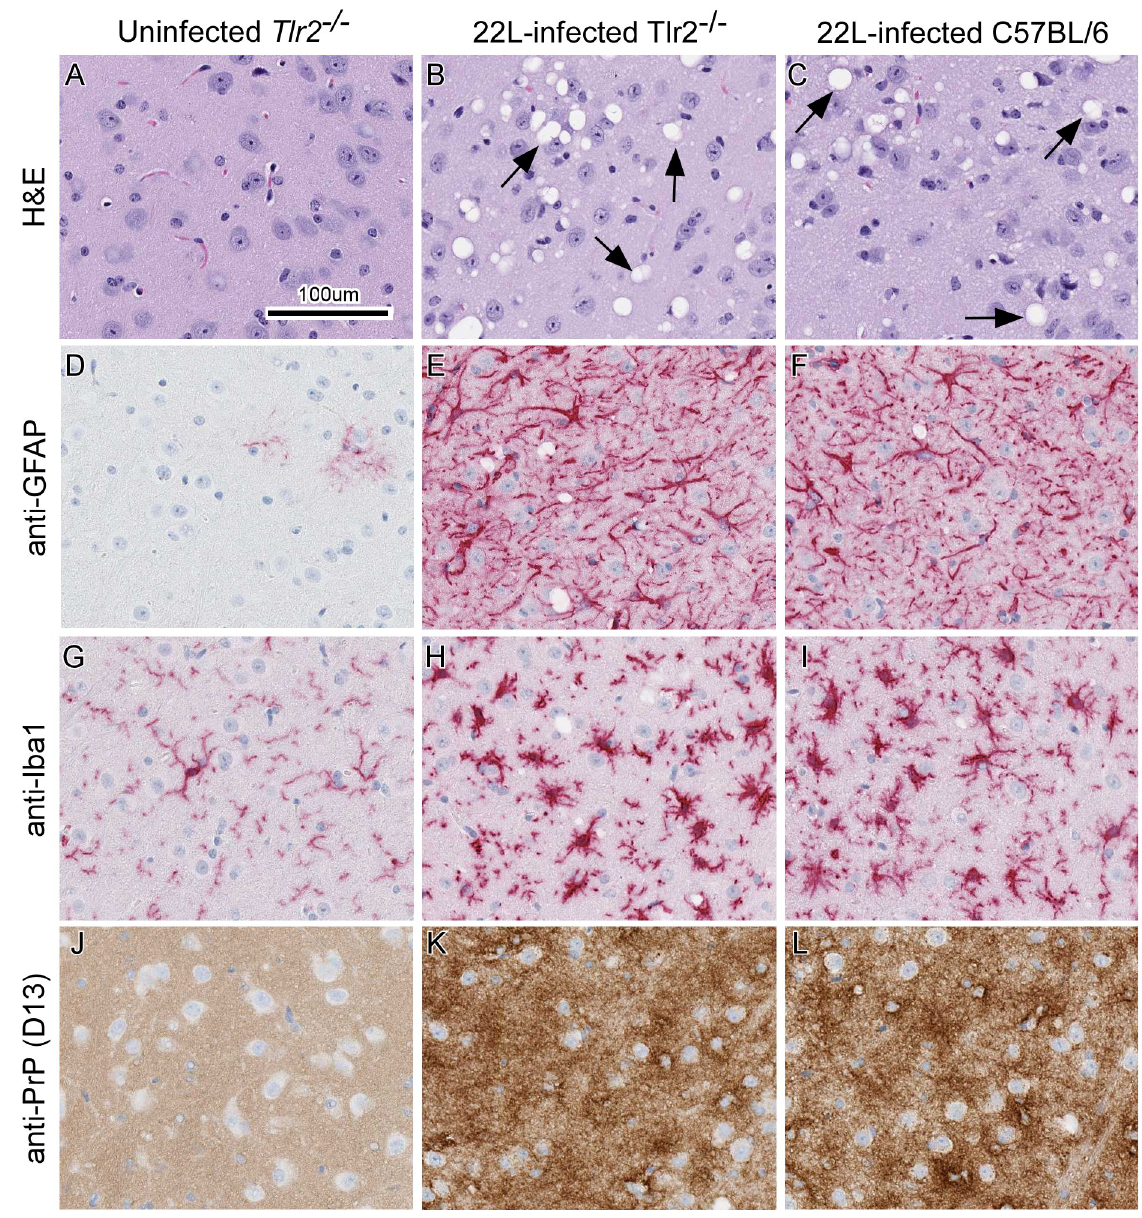
Fig 3. Representative neuropathology and immunohistochemical assessment of gliosis and PrP deposition in thalamic brain sections from uninfected and 22L-infected Tlr2 -/- mice compared to 22L-infected C57BL/6 controls. Tlr2 -/- mice were uninfected (panels A, D, G, and J) or infected with scrapie strain 22L (panels B, E, H, and K). For comparison C57BL/6 mice were also infected with strain 22L (panels C, F, I, and L). Sections of thalamus were stained by H&E (A-C) or probed with antibodies that recognize GFAP (D—F), Iba1 (G—I), and PrP (J —L). Representative images of the thalamus are shown for all at the same scale as indicated in panel A. Black arrows in panels B and C indicate vacuoles present in the neuropil of 22L-infected mice. Similar histopathological results were seen when 22L-infected C3ar1 -/- and C5ar1 -/- mice were compared to infected Balb/c control